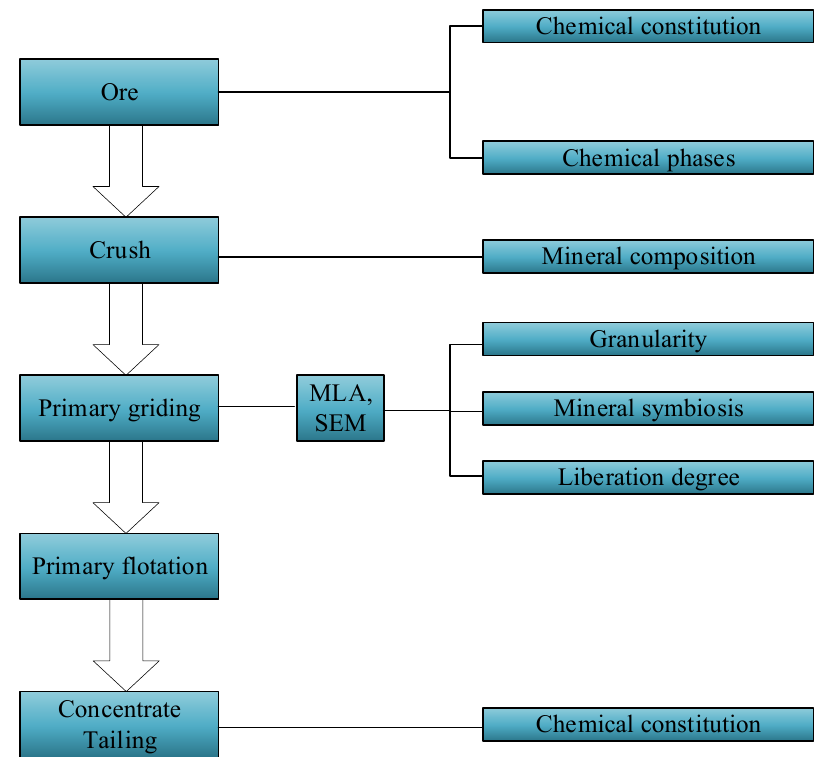
Figure 1. The technical route of the current